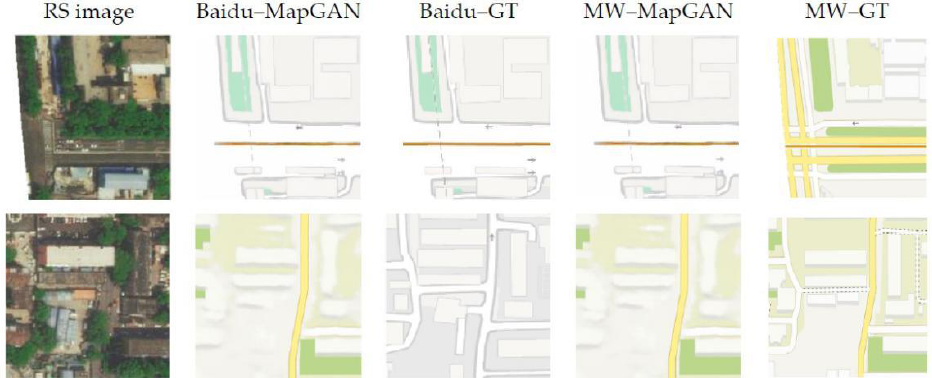
Figure 12. Comparison results of the Baidu and Map World maps generated by MapGAN before and after the removal of the classifier in the one-to-many map generation experiment. The images from left to right are remote sensing images, the Baidu maps generated by MapGAN, the real Baidu maps, the Map World maps generated by MapGAN, and the real Map World maps.